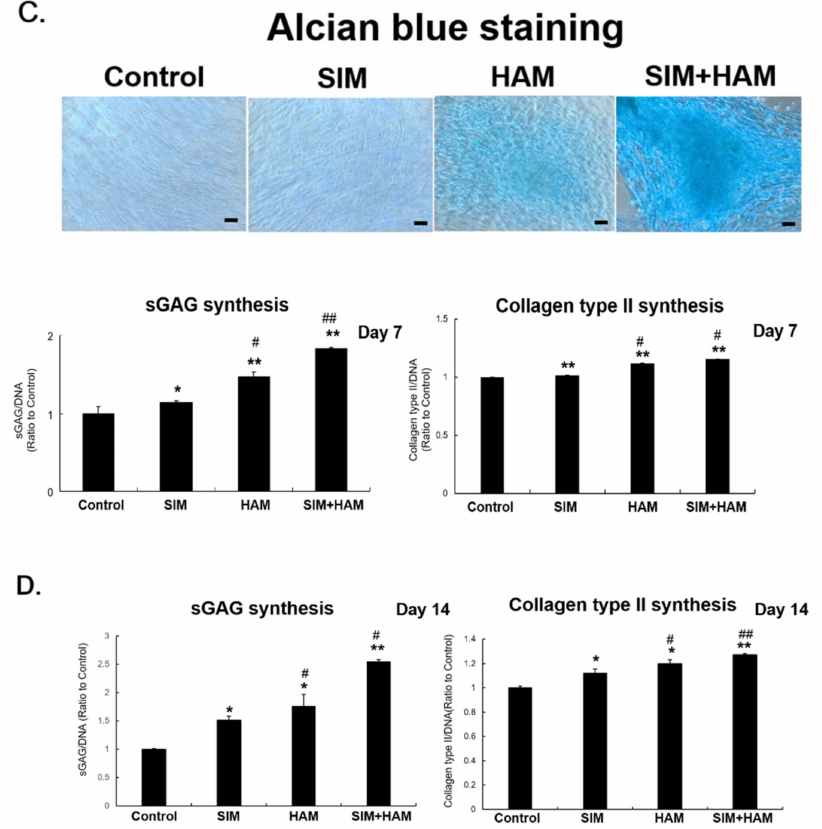
Figure 1. SIM plus HAM enhances the chondrogenesis of ADSCs. ADSCs were treated with SIM and cultured in wells with/without an HA coating, and the chondrogenesis of ADSCs was analyzed. ( A ) Cell aggregation of ADSCs in the control, SIM, HAM and SIM+HAM groups at 4 h (scale bar = 200 µ m). ( B ) The mRNA expression levels of chondrogenic genes (aggrecan and collagen type II) in the control, SIM, HAM and SIM+HAM groups on day 3. The gene expression levels are expressed relative to those in the control group, which are defined as 1. ( C ) Alcian blue staining of sGAG in the control, SIM, HAM and SIM+HAM groups on day 7. Blue: Alcian blue staining (scale bars = 200 µ m). sGAG synthesis and collagen type II synthesis by ADSCs were quantified with a DMMB assay and an ELISA kit, respectively. The abundance of synthesized sGAG or collagen type II normalized to the total DNA concentration in each group is expressed as the sGAG/DNA or collagen type II/DNA ratios. The sGAG/DNA and collagen type II/DNA ratios are expressed relative to that in the control group on day 7, which is defined as 1. ( D ) ADSCs were embedded in a 3D HA-enriched fibrin hydrogel (HA/Fibrin) and treated with SIM in chondrogenic medium for 14 days. sGAG synthesis and collagen type II synthesis by ADSCs were quantified with a DMMB assay and an ELISA kit, respectively. The abundance of synthesized sGAG or collagen type II normalized to the total DNA concentration in each group is expressed as the sGAG/DNA or collagen type II/DNA ratios. The sGAG/DNA and collagen type II/DNA ratios are expressed relative to that in the control group on day 14, which is defined as 1. The values presented are the means ± SEMs ( n = 6). (*) and (**) indicate p < 0.05 and p < 0.01, respectively, compared with the control group. (#) and (##) indicate p < 0.05 and p < 0.01, respectively, compared with the SIM